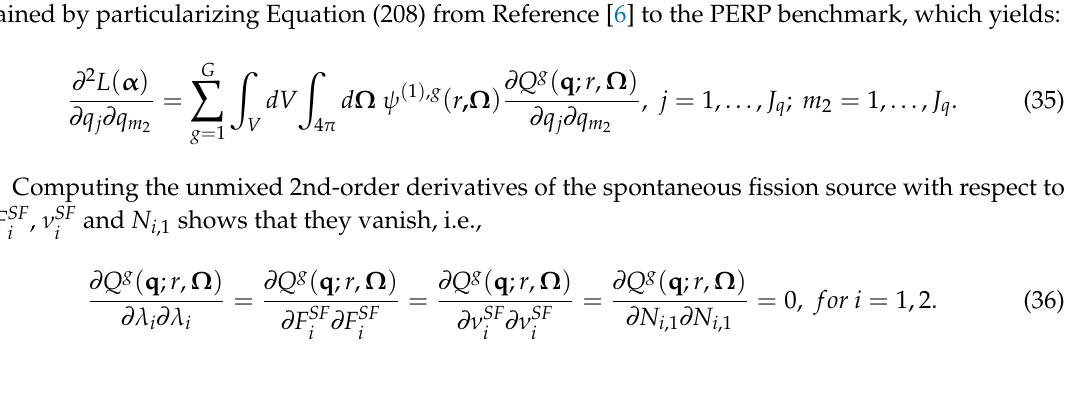
Table 5. First-order relative sensitivities S ( 1 )